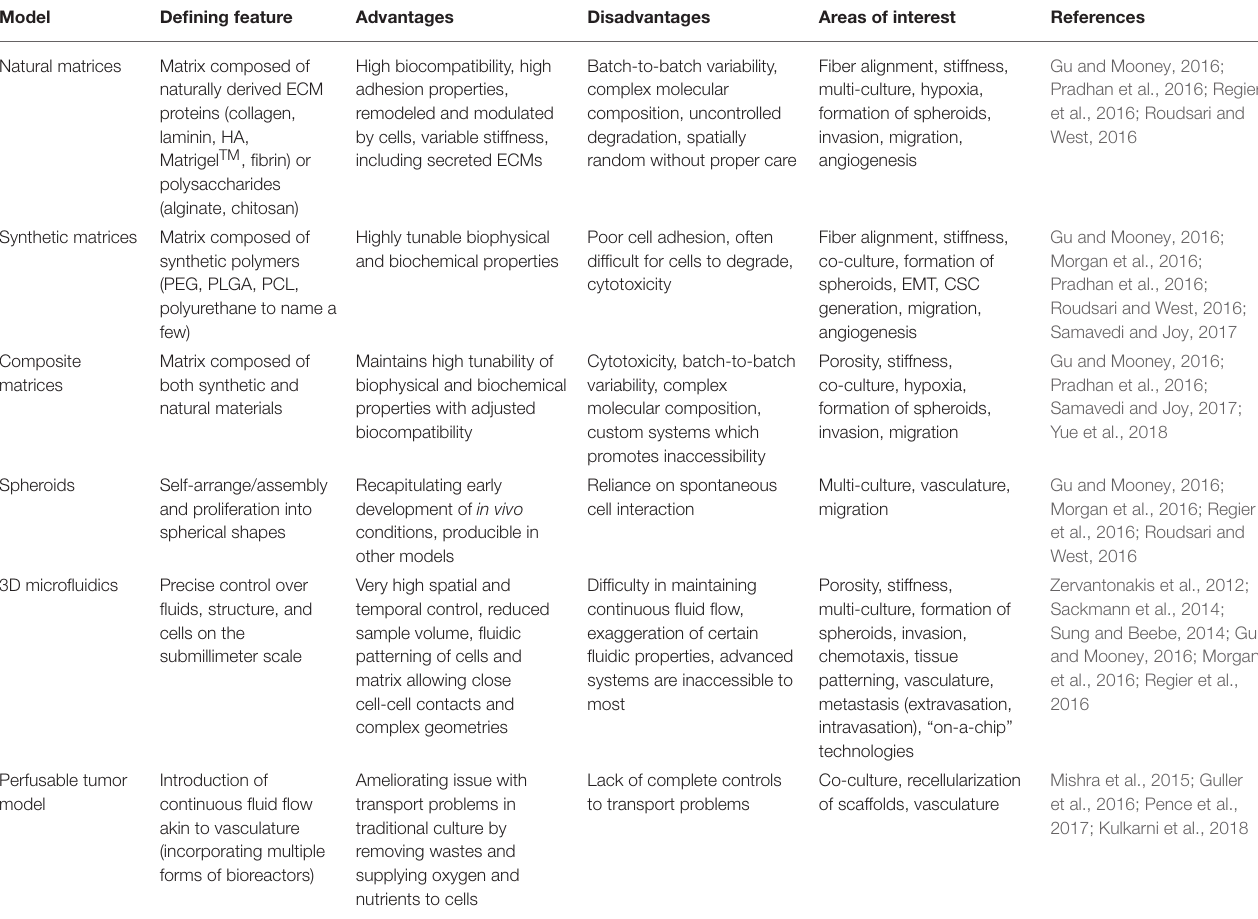
TABLE 5 | Comparison of 3D in vitro model platforms of breast cancer